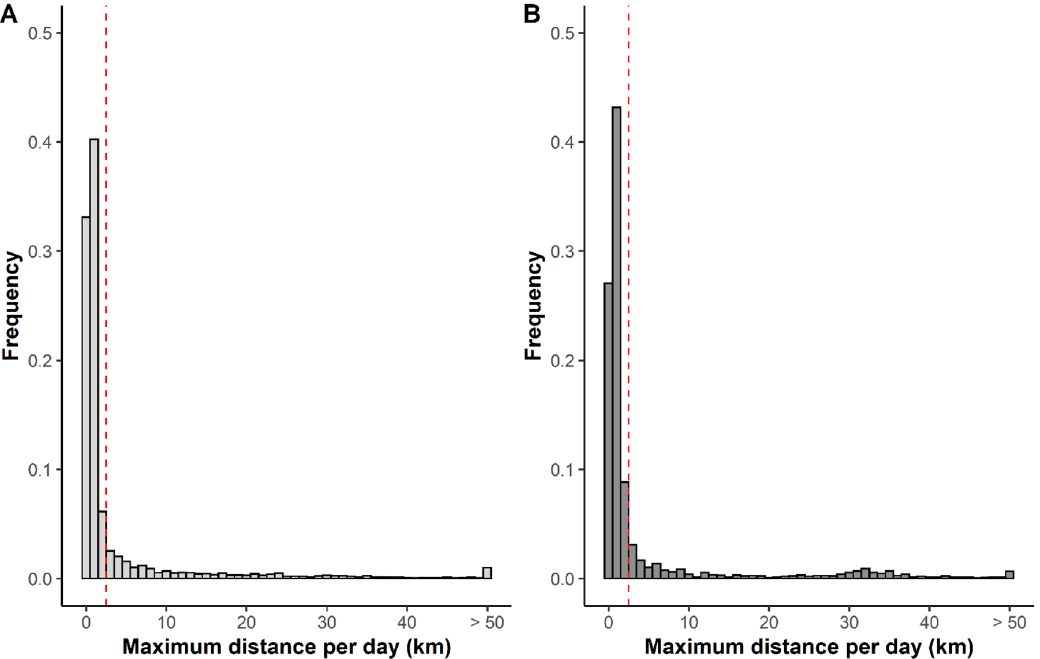
Figure 2. Frequency of the maximum daily distance (in Km’s) moved by (A) immature and (B) adult Shoebills. The dashed red line indicates the threshold that captures 80% of movements, used to define Shoebills’ moving days.